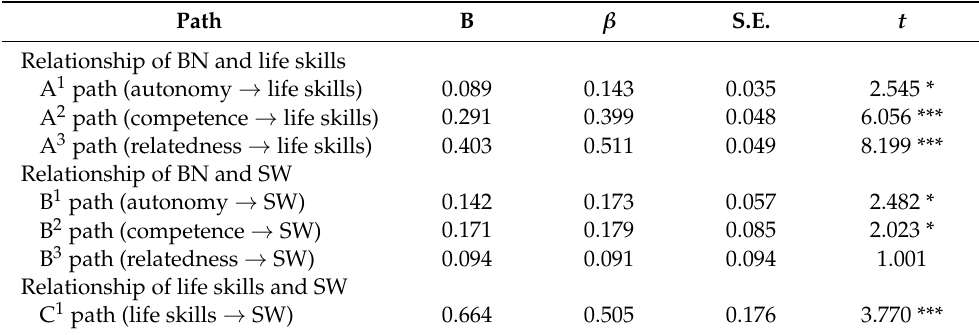
Table 3. Standardized and unstandardized estimates, standard error, and p-value within the models. Path B β S.E. t